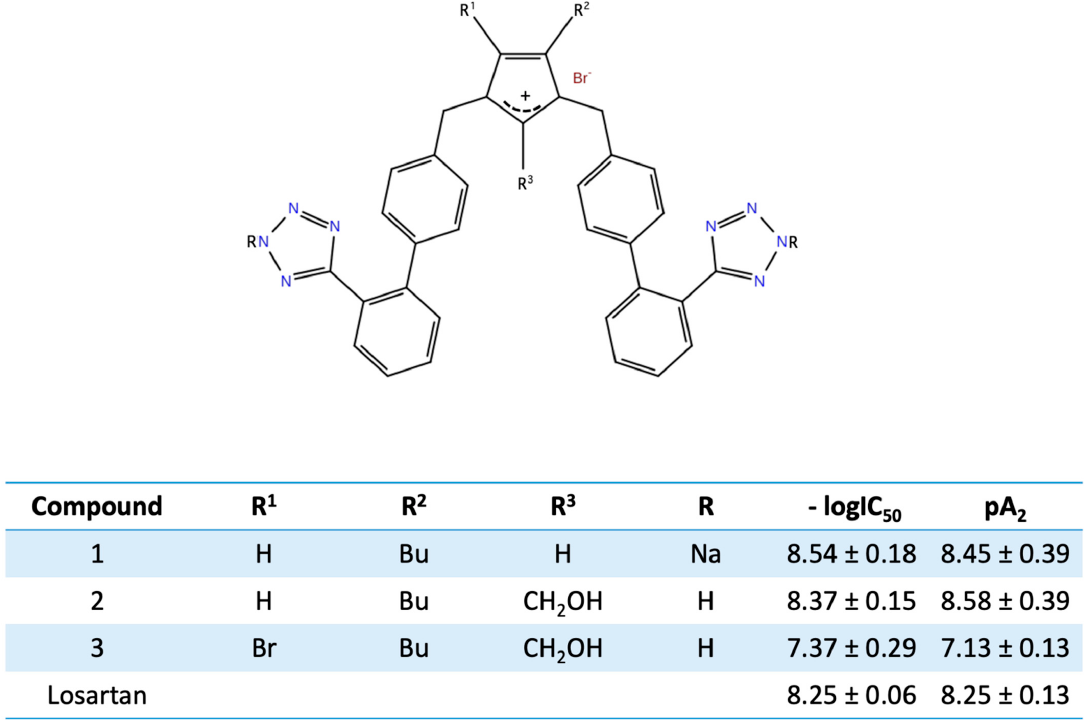
Figure 12. Structures and biological activities of bis alkylated losartan ( 1 ) and losartan V8 analogs ( 2 , 3 ).